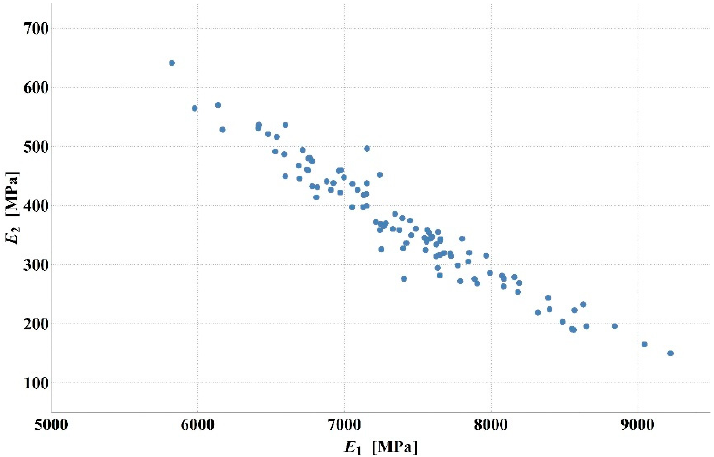
Figure 3. Values of asphalt layer and aggregate base course stiffness moduli for D1S variant of measurement error.